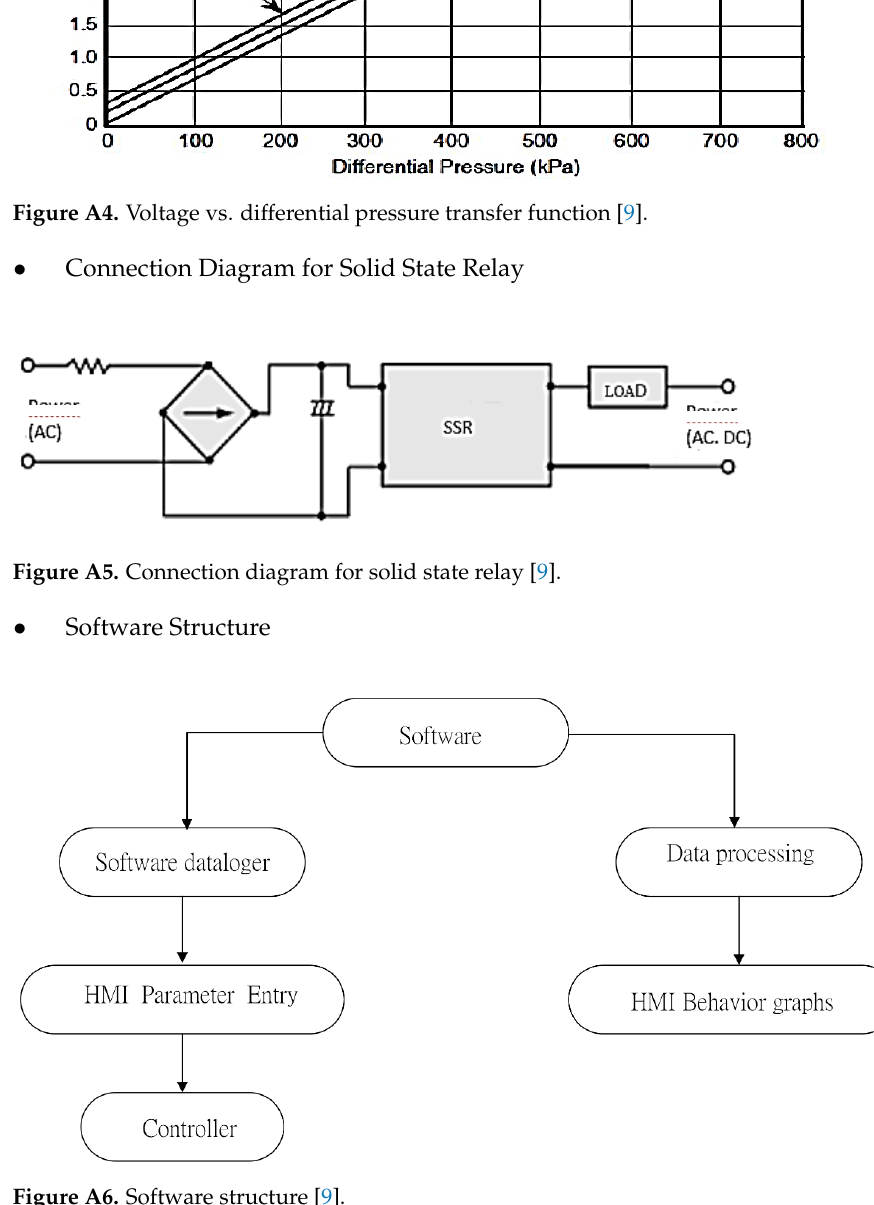
Figure A6. Software structure [9].